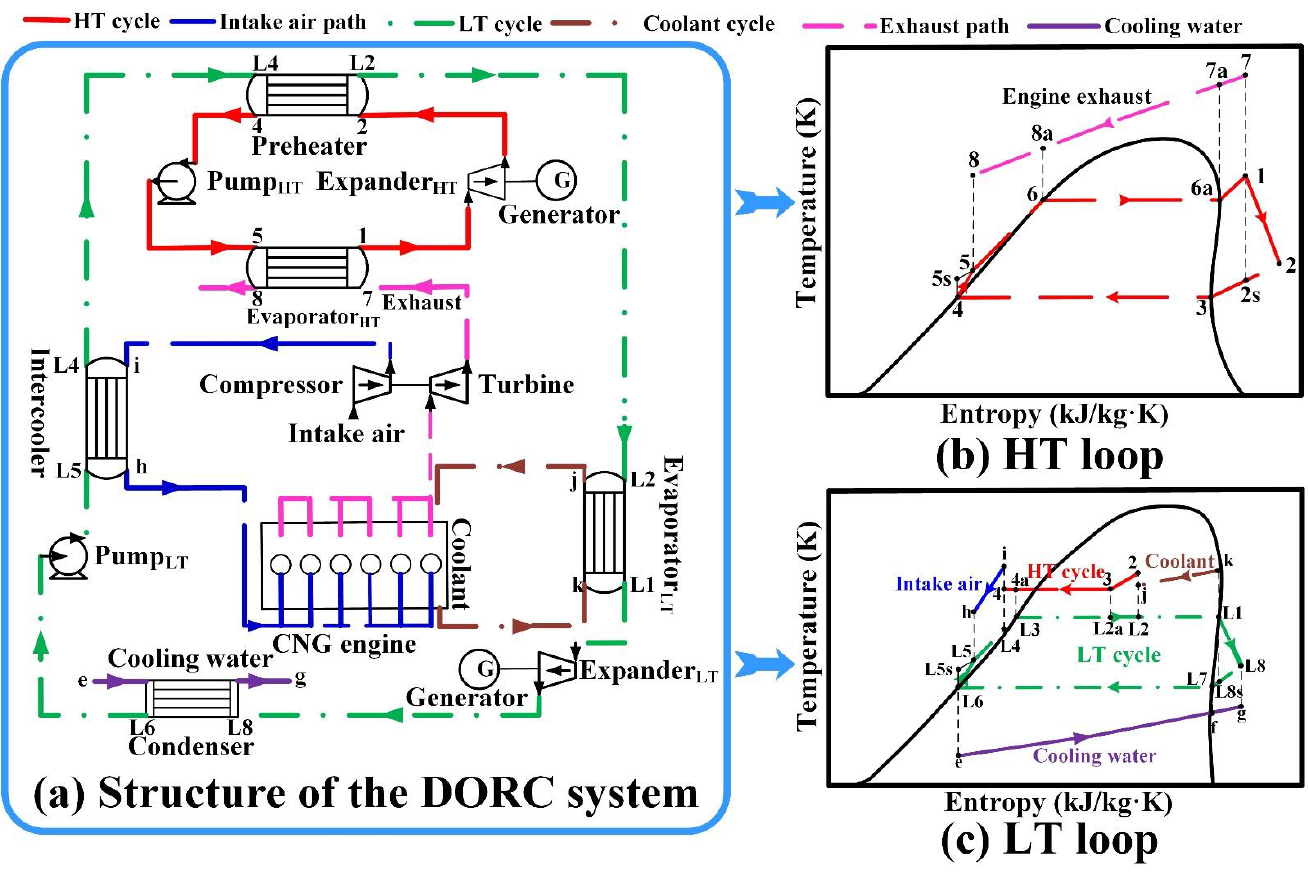
Figure 1. Topology and thermodynamic cycle of DORC. ( a ) structure of the DORC system. ( b ) HT loop. ( c ) LT loop.